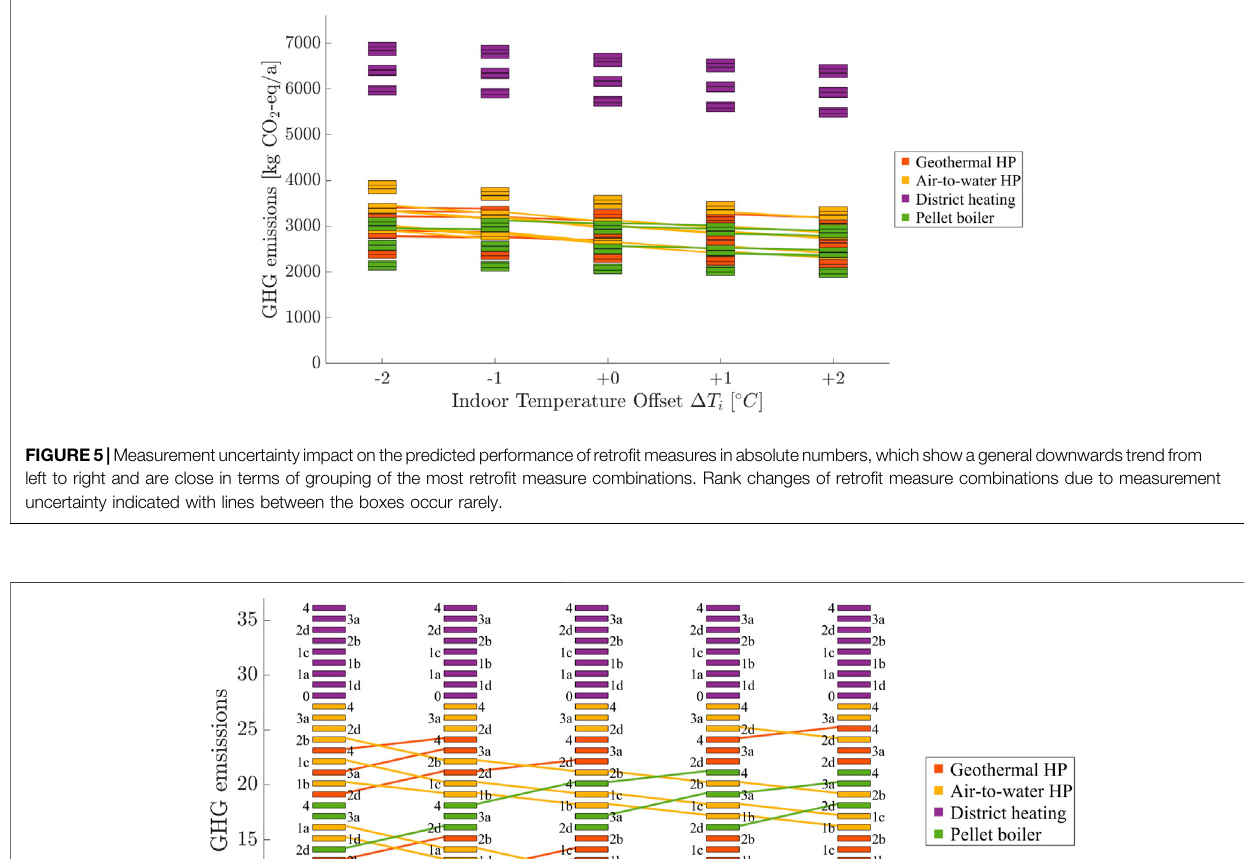
Frontiers in Built Environment |